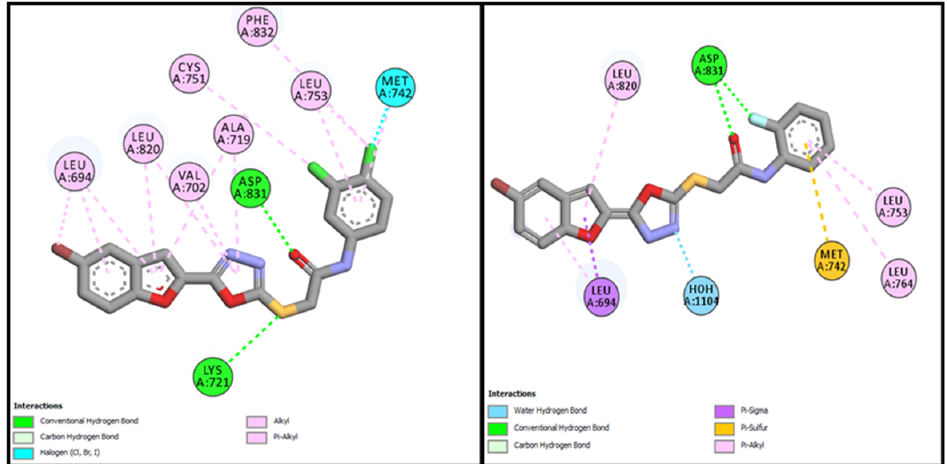
Figure 6. Two-dimensional interactive poses of BF-2 ( Left ) and BF-6 ( Right ) in the EGFR active site.